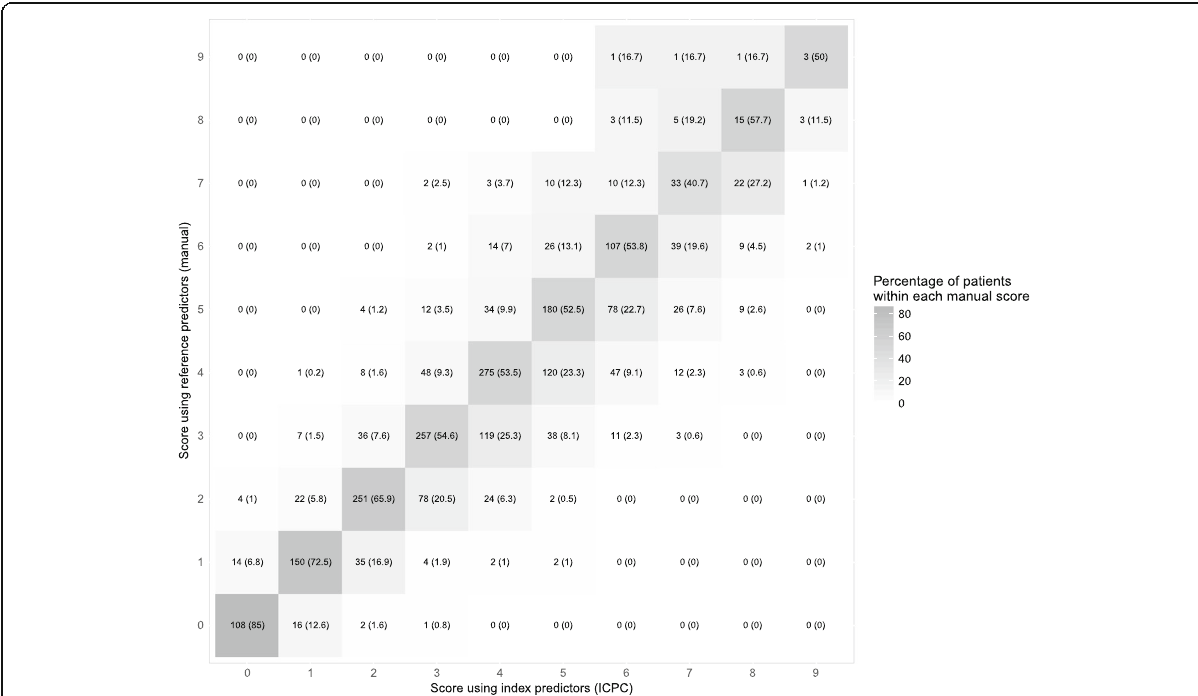
Fig. 1 The concordance of CHA2DS2-VASc scores as calculated using the index predictors ( x -axis) and as calculated using the reference predictors ( y -axis). Numbers are counts (percentages)